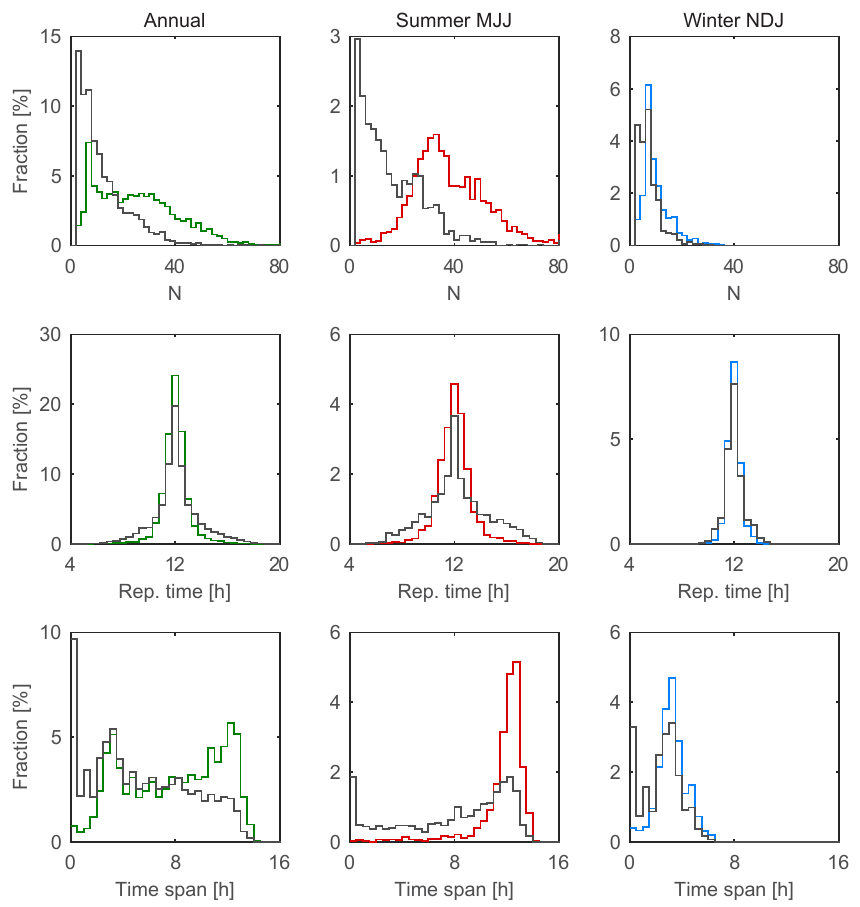
Figure 2. Histograms of the number of contributing observations ( N , first row), representative observation time (second row), and time span of contributing observations (third row) for 2000–2016 for all months (first column), summer months (May–June–July, second column), and winter months (November–December–January, third column). Grey traces show results from the traditional method, and coloured traces show results for the methodology described in the present